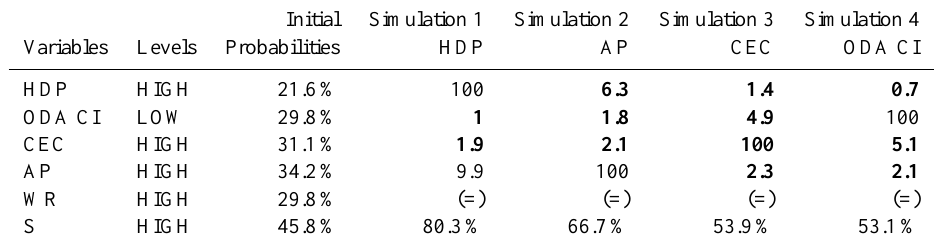
Table 3. General model – sanitation simulations. In bold, the positive variations of